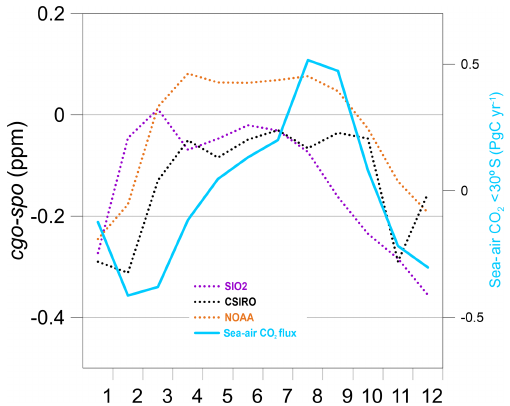
Figure 8. Composite 25-year average of monthly baseline cgo–spo CO 2 (dark blue). Individual network values are shown in orange (NOAA), dark blue (SIO2), and CSIRO (black). Estimates of sea– air CO 2 flux seasonality are shown in light